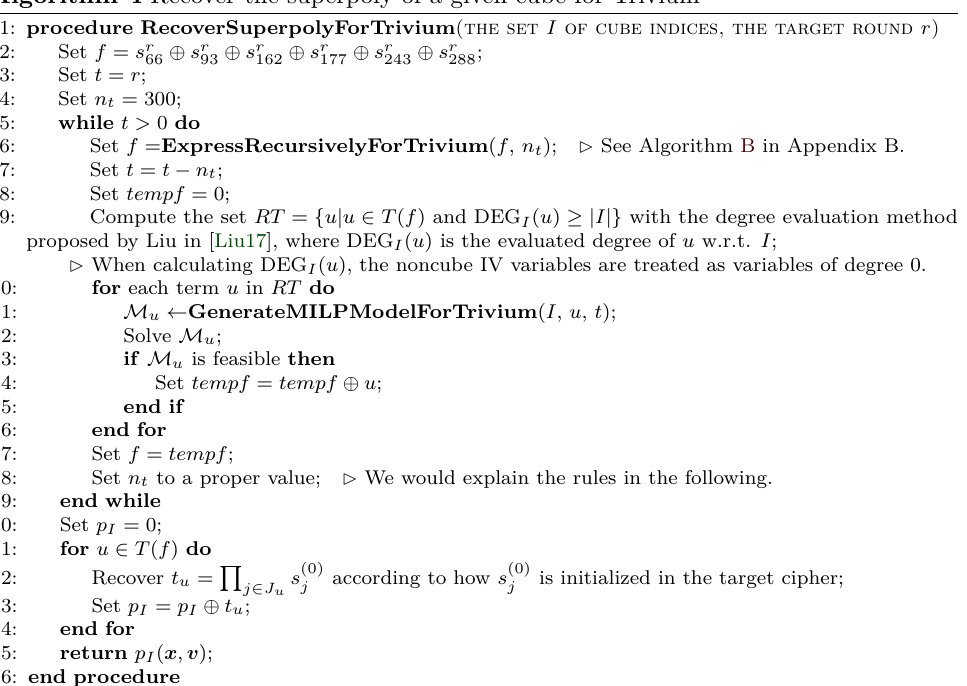
Algorithm 4 Recover the superpoly of a given cube for